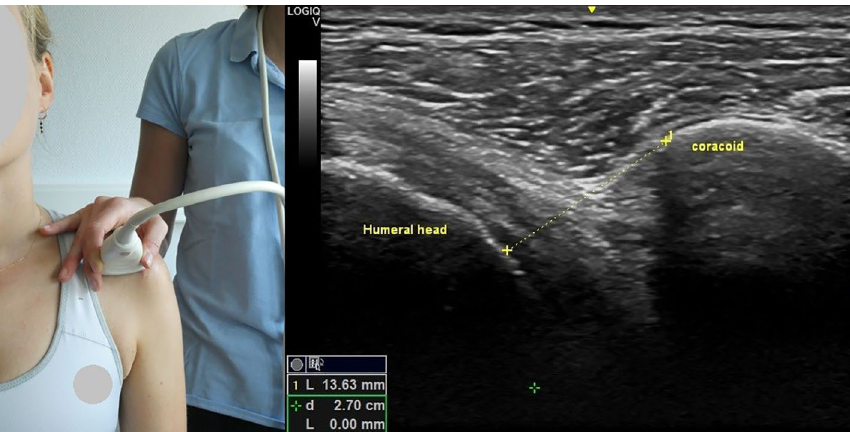
Figure 1. Left: position of the probe during the measurement of the coracohumeral distance at rest; right: measurement of coracohumeral distance at rest. Photo on the left side by Anthe